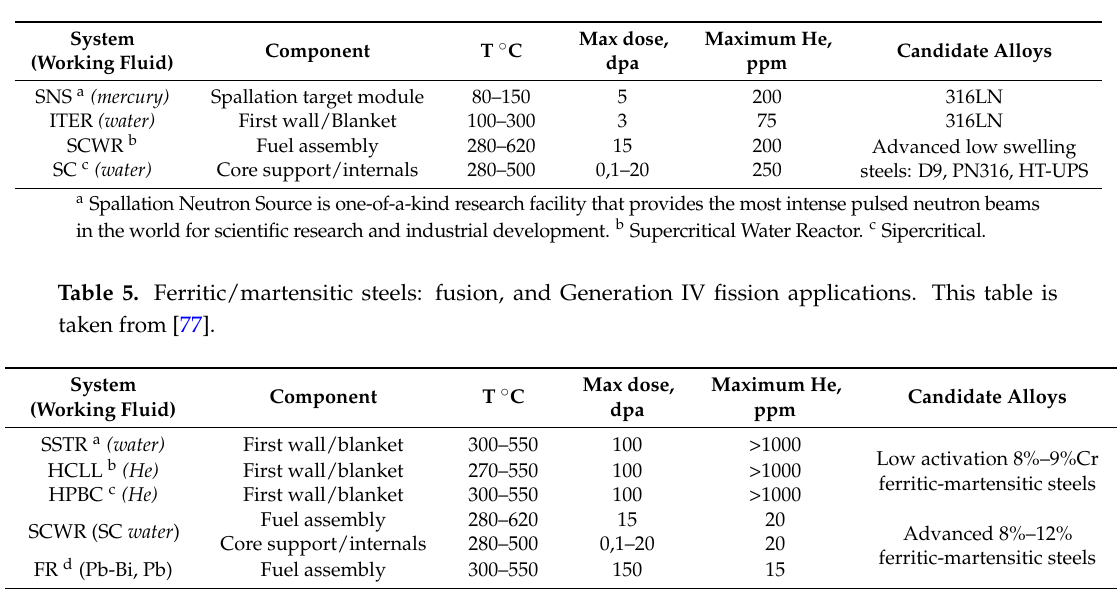
Table 4. Austenitic stainless steels: spallation, fusion, and Generation IV fission applications. Asterisks indicate conditions set for removal of first target. Later targets may be subjected to higher doses and transmutation levels with experience gained in conditions specific to SNS. This table is taken from [78].